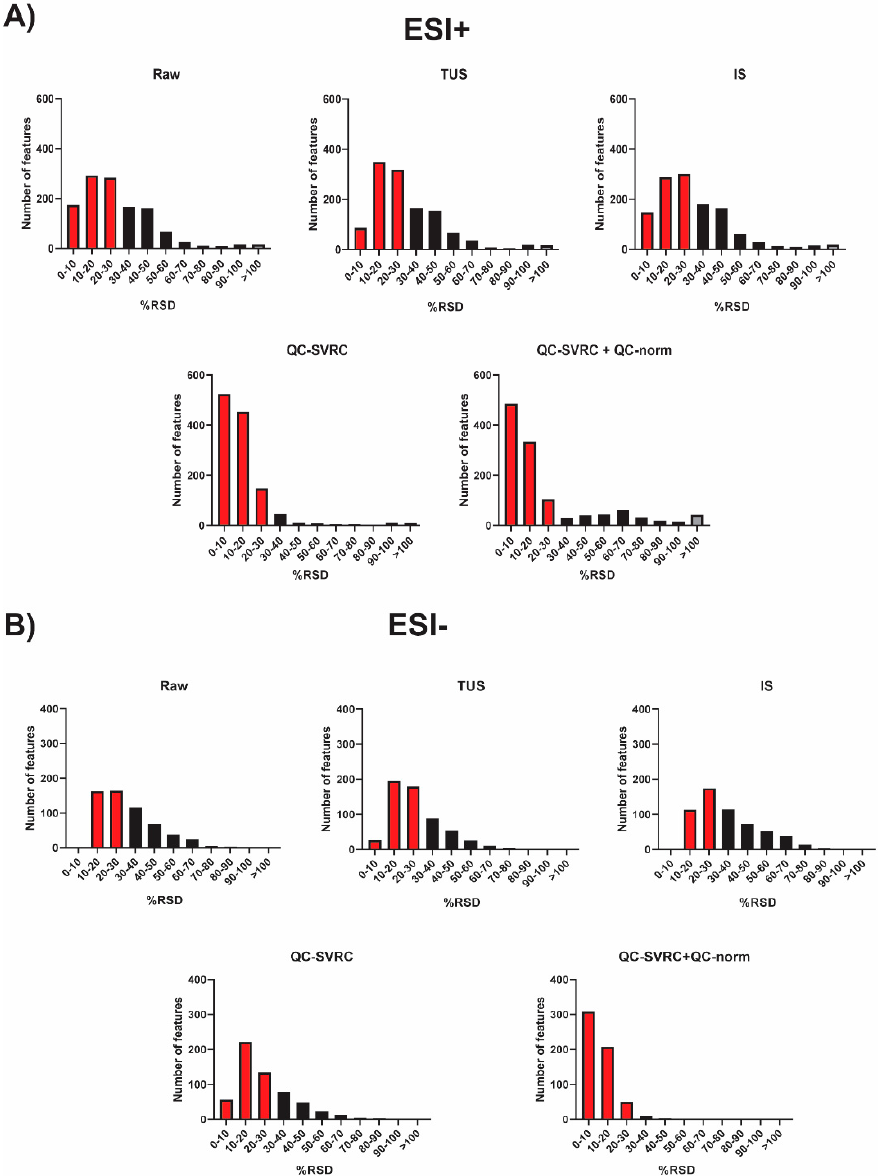
Figure 6. RSD distribution across QC samples from the complete dataset after each normalization method. ( A ) ESI + mode and ( B ) ESI − mode. The red and grey bars indicate peaks that fall under RSD < 30% and RSD > 100%, respectively.